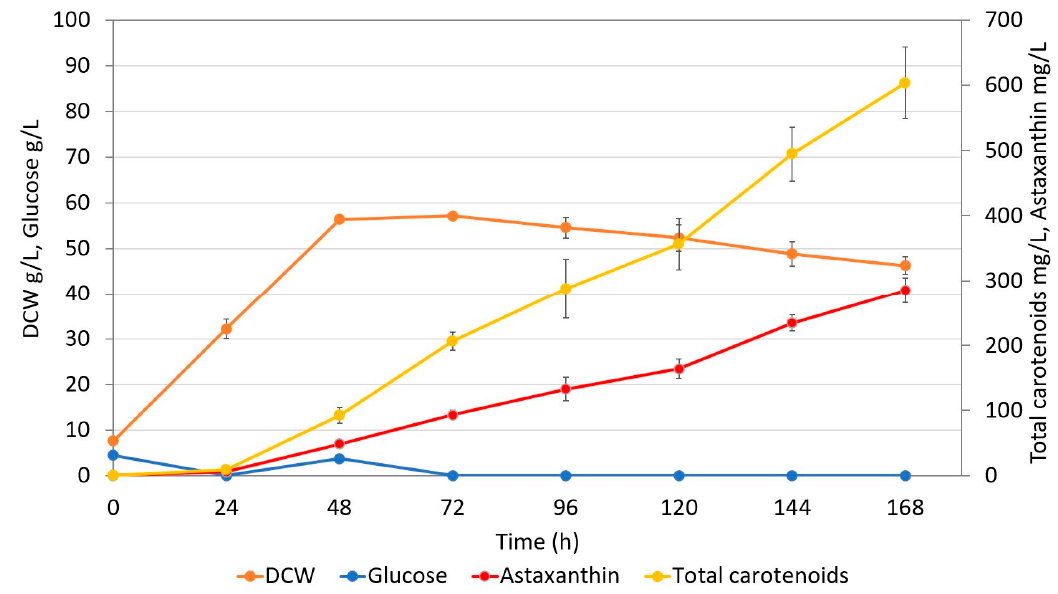
Figure 7. Concentrations of dry cell weight (DCW), glucose, and carotenoids during the fed-batch cultivations of ST7976 (iso 3). The values are averages from three independent experiments; the error bars represent show standard deviations.